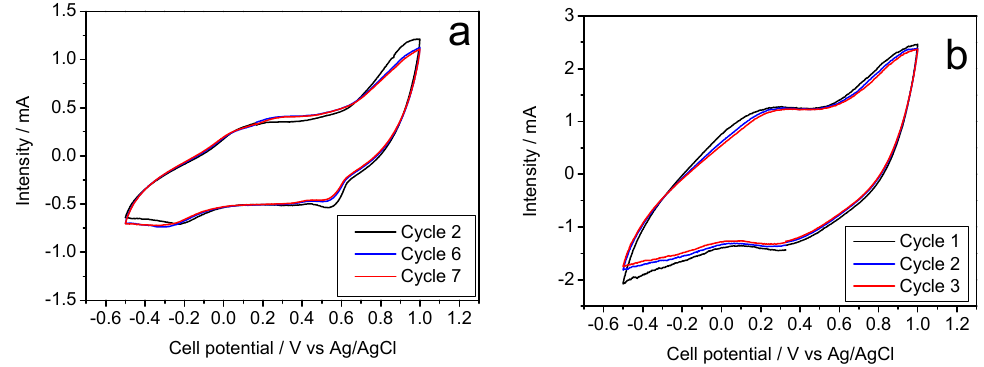
Figure 5. Cyclic voltammetry in aqueous Na 2 SO 4 -based electrolyte and referring the voltages to the Ag/AgCl electrode: ( a ) Na-B/SS starting with ( b ) K-B/SS.